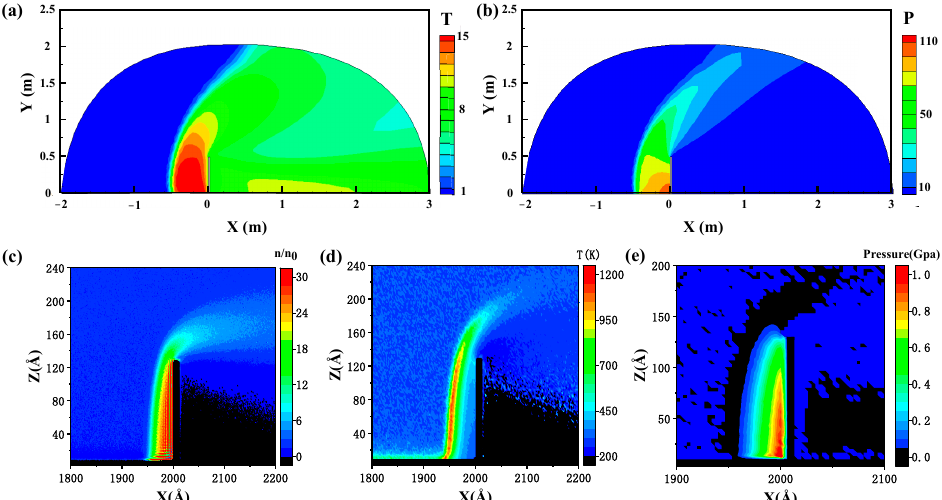
Figure 2. Reentry hypersonic flow field (Ma ∞ = 8.37, Kn ∞ = 0.01) of vertical plate in near-continuum transition flow solved by GKUA in ( a , b ). ( a ) Temperature distribution of outflow field; ( b ) Pressure distribution of outflow field. T and P translate to actual temperature and pressure values by Formulas (2) and (3). Reentry hypersonic flow field (Ma ∞ = 3.2, Kn ∞ = 0.2) of vertical plate in near-continuum transition flow solved by MD simulation in ( c – e ). ( c ) Number density distribution of outflow field; ( d ) Temperature distribution of outflow field; ( e ) Pressure distribution of outflow field.